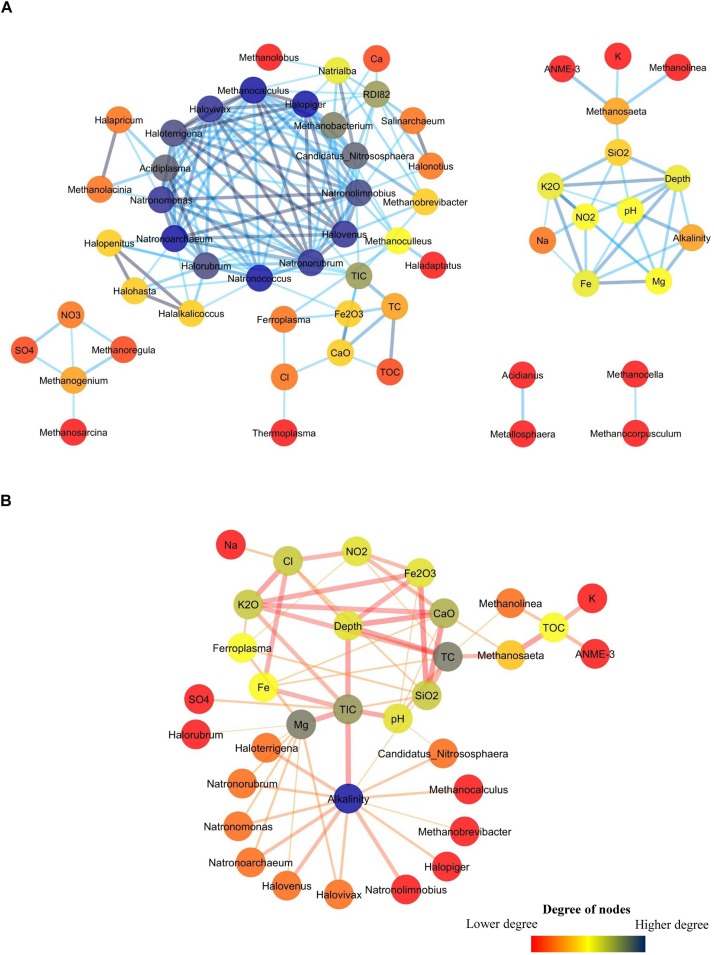
Co-occurrence network among archaeal genera and geochemical parameters in subsurface rock cores of Koyna–Warna region. The color of the nodes represent the number of degrees it has. (A) Network showing positive correlation. (B) Network showing negative correlation.